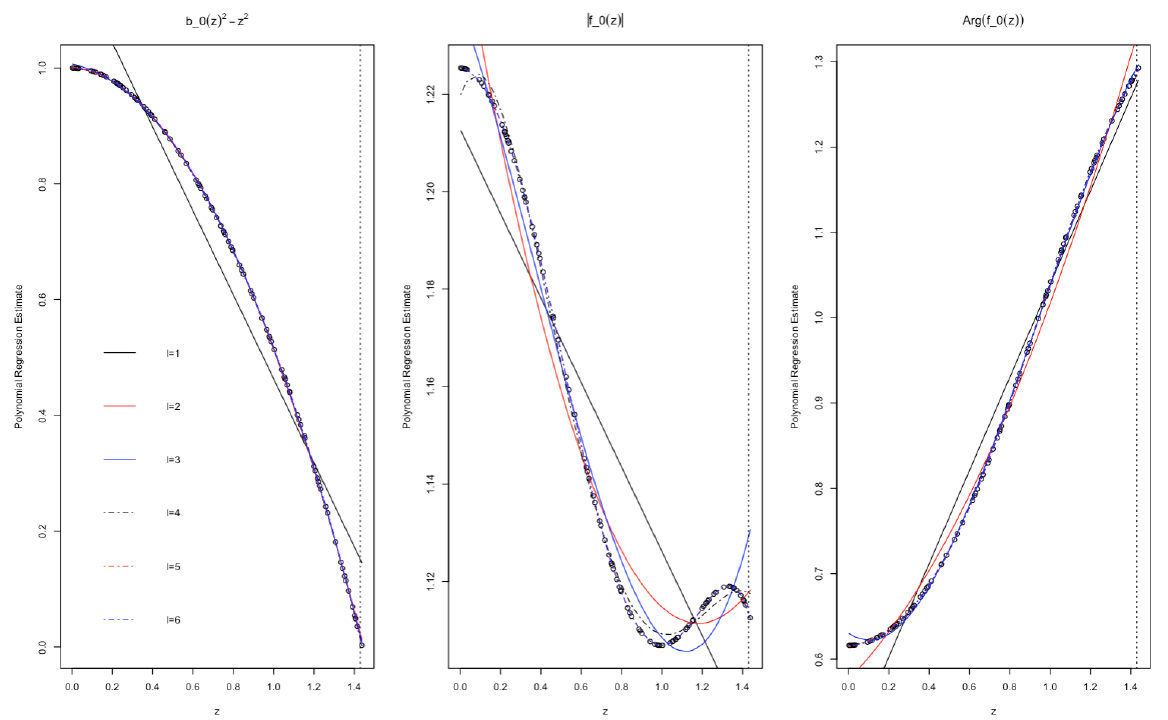
Figure 2. The estimates of critical collapse functions corresponding to α solution of hyperbolic case based on a polynomial regression method of orders l = { 1, . . . ,6 } based on a training sample of size n =